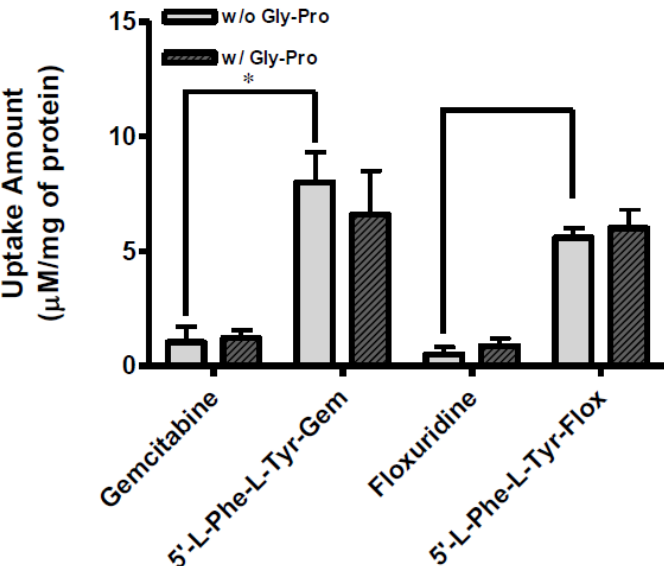
Figure 4. The uptake study with floxuridine, 5 ′ - L -phenylalanyl- L -tyrosyl-floxuridine, gemcitabine, and 5 ′ - L -phenylalanyl- L -tyrosyl-gemcitabine found in AsPC-1 cells with 1 h incubation with the presence and the absence of 10 mM Gly-Pro. Each column represents the total amount of gemcitabine prodrug, gemcitabine, and cytosine. Data are expressed as the amount, µM/mg of protein, mean ± SD, n = 3. * p < 0.05, the uptake amount of dipeptide prodrugs is compared with their parents, floxuridine and